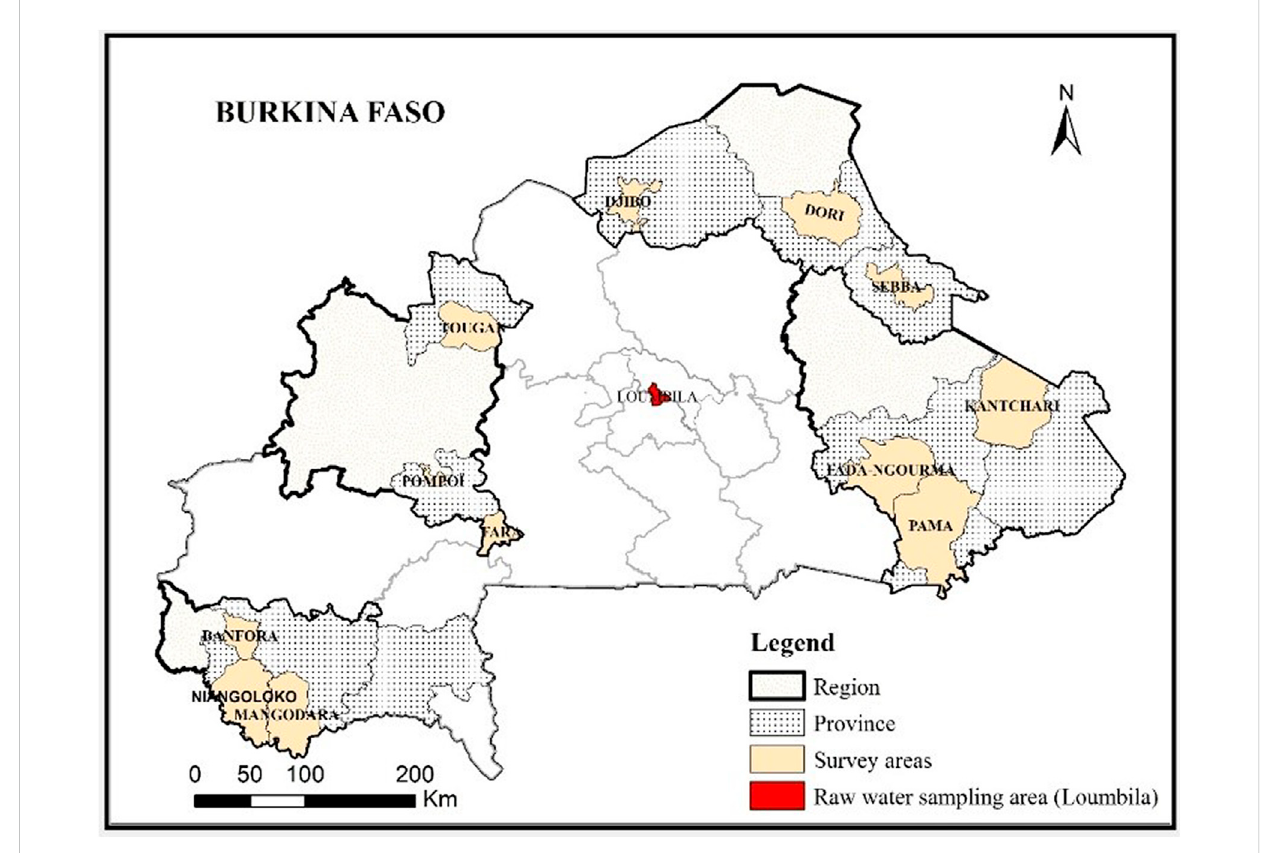
FIGURE 1 Localization of the different survey areas.